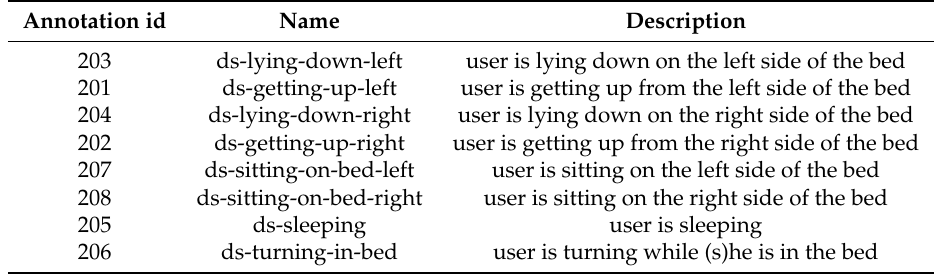
Table 4. List of activities labeled by the user living in the apartment, where location_id = 416 and name = ORU/Angen